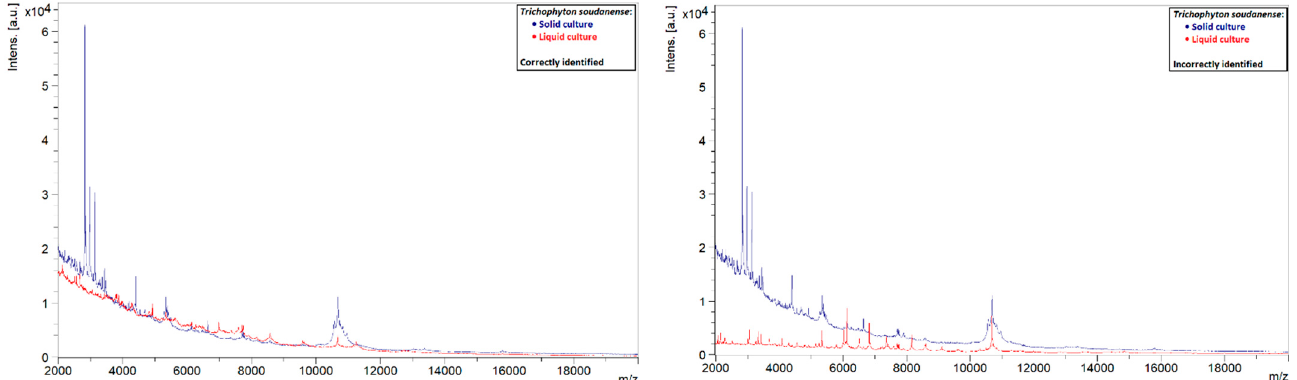
Figure 6. Comparison of the spectra of solid and liquid cultures of M. canis , on the left a correctly identified liquid culture and on the right an incorrectly identified liquid culture.